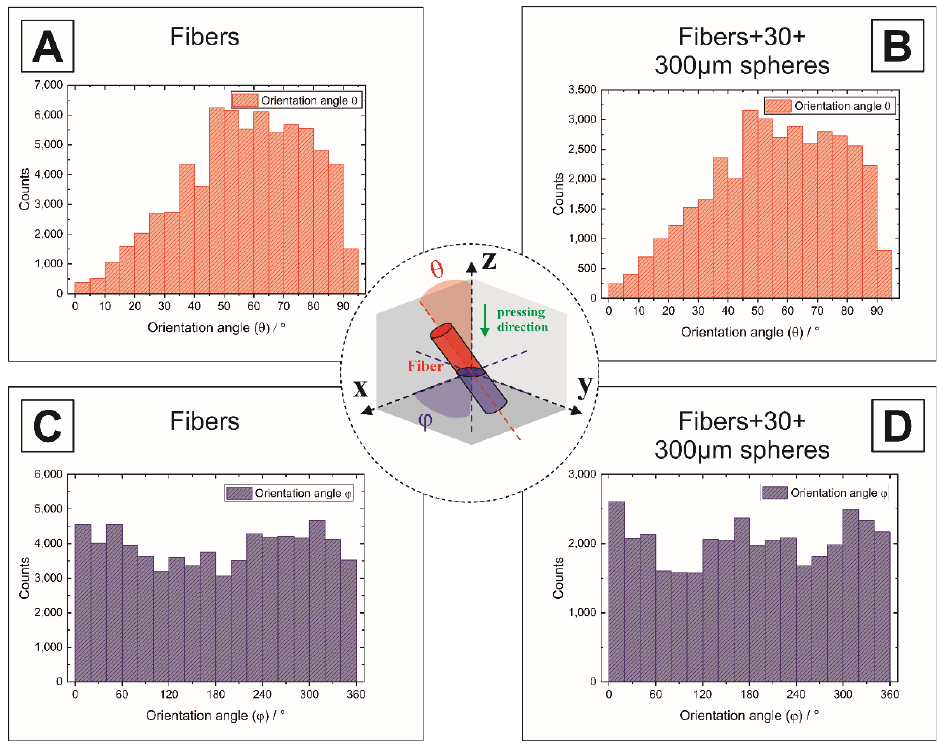
Figure 6. Orientation of the fibrous pores in the 3D volume analyzed by µCT: ( A , B ) show the fibrous pore orientation (angle θ ) towards the z -axis, ( C , D ) show the fiber orientation (angle ϕ ) within the xy-plane.